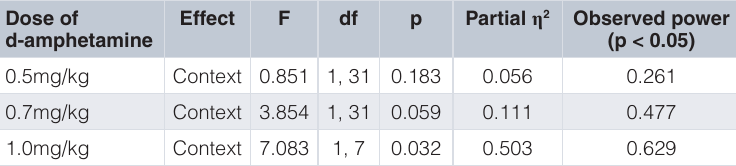
Table 1. Statistical results for Experiment